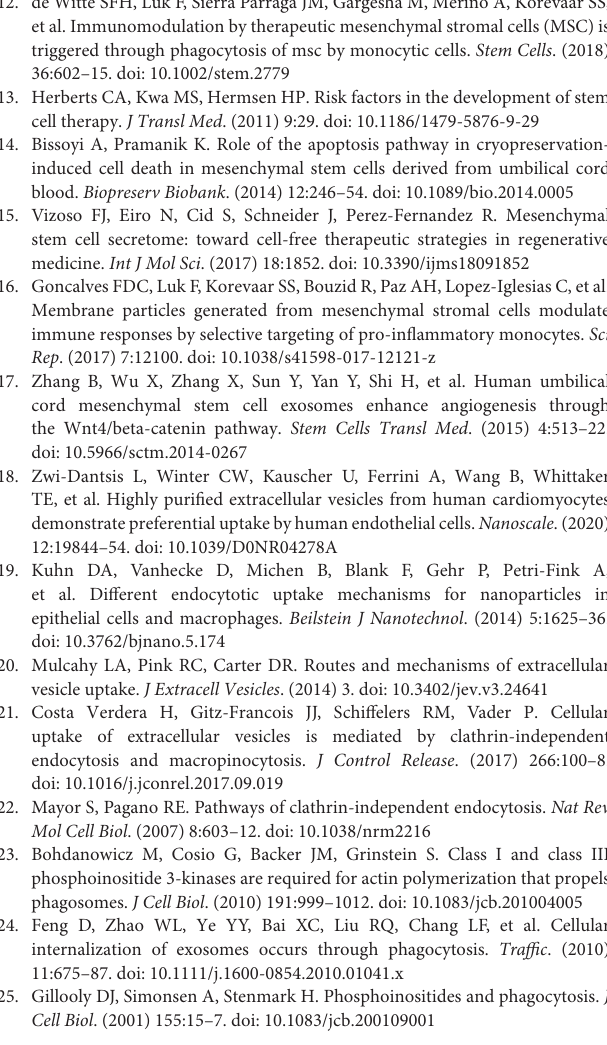
Supplementary Figure 1 | Characterization of MP and PKH-MP. (A) Nanoparticle tracking analysis (NTA) profile of MP and PKH-MP. (B) The size distribution of MP and PKH-MP. Supplementary Figure 2 | Macrophages and HUVEC viability after treating with selective inhibitors. Cells were preincubated for 30min in complete medium containing Heparin (0.1–100 µ g/ml), Dynasore (20–160 µ M), Chlorpromazine (1–50 µ M), Nystatin (5–40 µ g/ml), Cytochalasin D (0.25–2 µ M), or Wortmannin (0.1–10 µ M). PBS and 0.1% DMSO were used as a control. Cell viability was